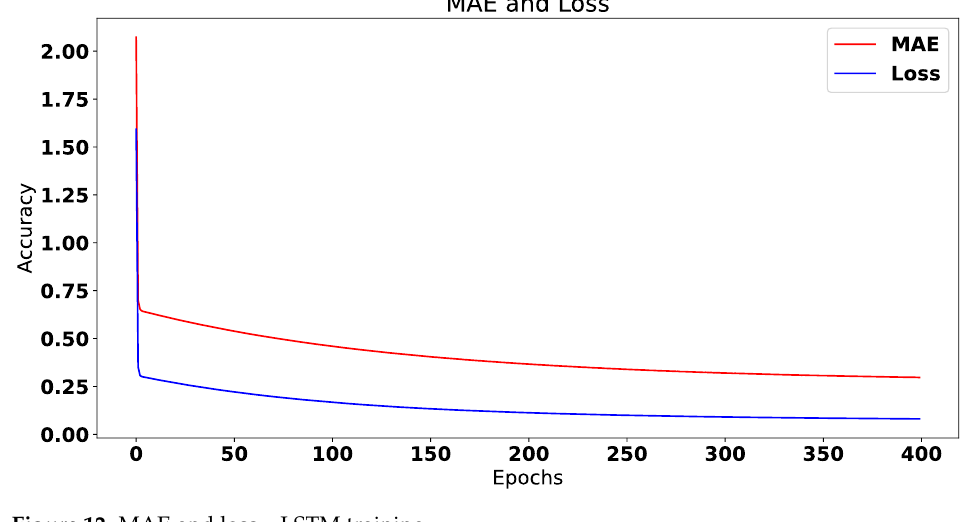
Figure 13. MAE and loss - RNN training